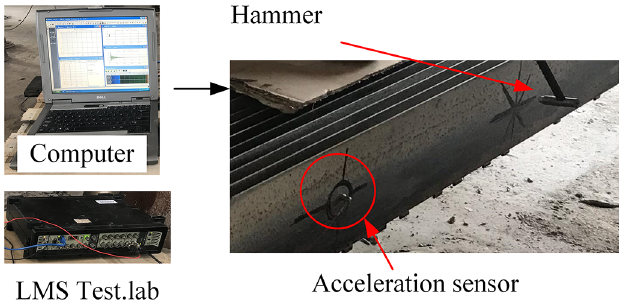
Fig. 9. Experimental measurement setup of the saw blade frequency.